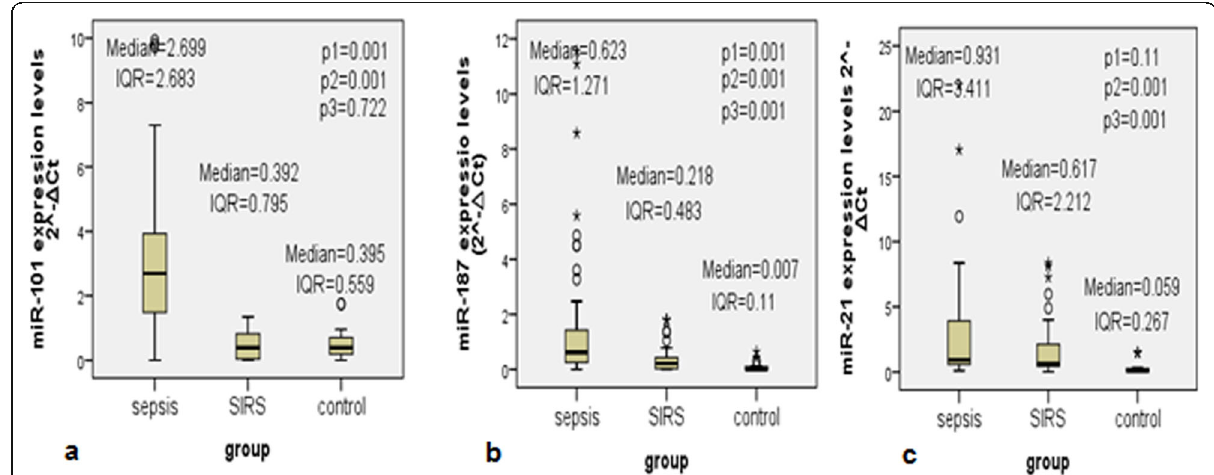
Fig. 1 Comparison of the normalized expression levels of miRNAs 101, 187, and 21 (2 −Δ Ct ) among sepsis, SIRS, and control groups. IQR, interquartile range; p1 , sepsis group and SIRS group; p2 , sepsis group and control group; p3 , SIRS group and control